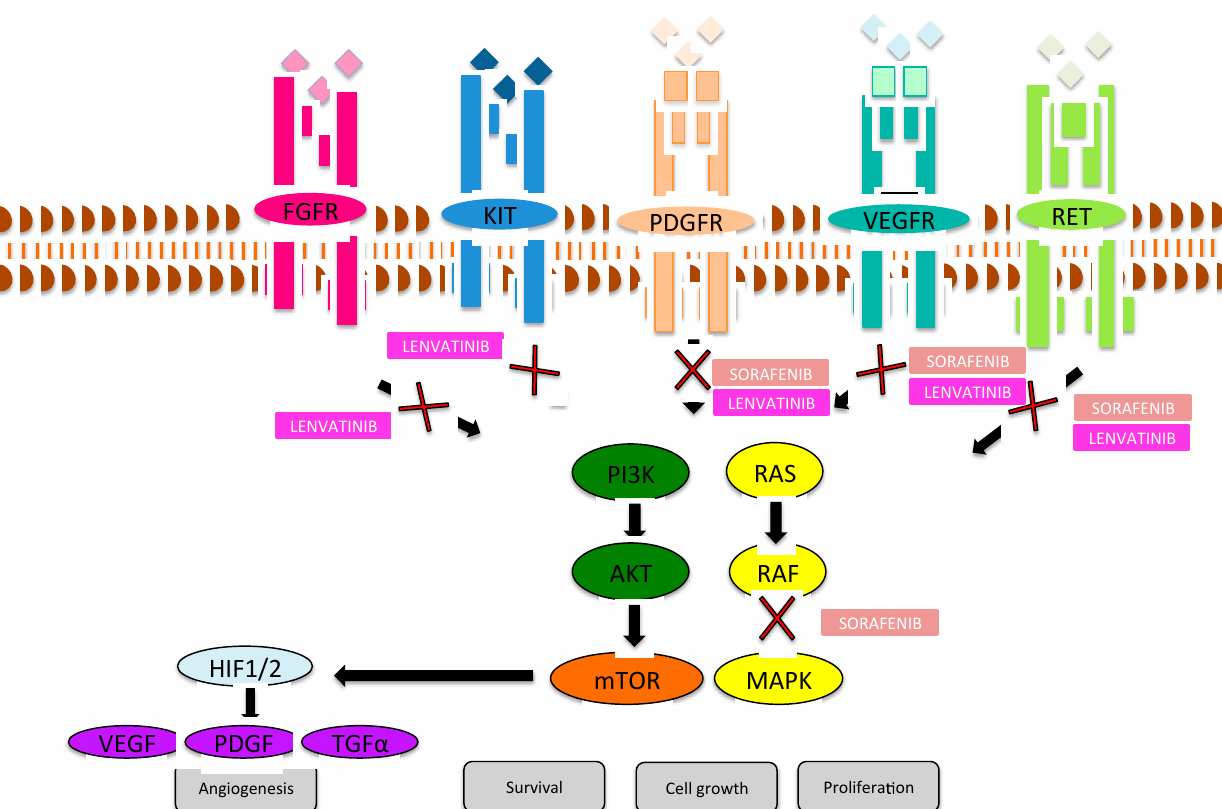
Figure 1. Molecular pathways of multikinase inhibitors (MKIs) in radioactive iodine refractory differentiated thyroid cancer. The MKIs (sorafenib, lenvatinib) block signaling from the tyrosine kinase receptors, preventing cell survival, growth, proliferation and angiogenesis. Abbreviations: AKT, protein kinase B; FGFR, fibroblast growth factor receptor; HIF, hypoxia-inducible factor; MAPK, mitogen activated protein kinase; mTOR, mammalian target of rapamycin; PDGFR, platelet-derived growth factor receptor; PI3K, phosphoinositide 3-kinase; RAF, rapidly accelerated fibrosarcoma kinase; RAS, rat sarcoma protein; RET, rearranged during transfection receptor protein; TGF, tumor growth factor; VEGFR, vascular endothelial growth factor receptor. The signaling pathways inhibited by the indicated drugs are represented by crossed-out arrows.